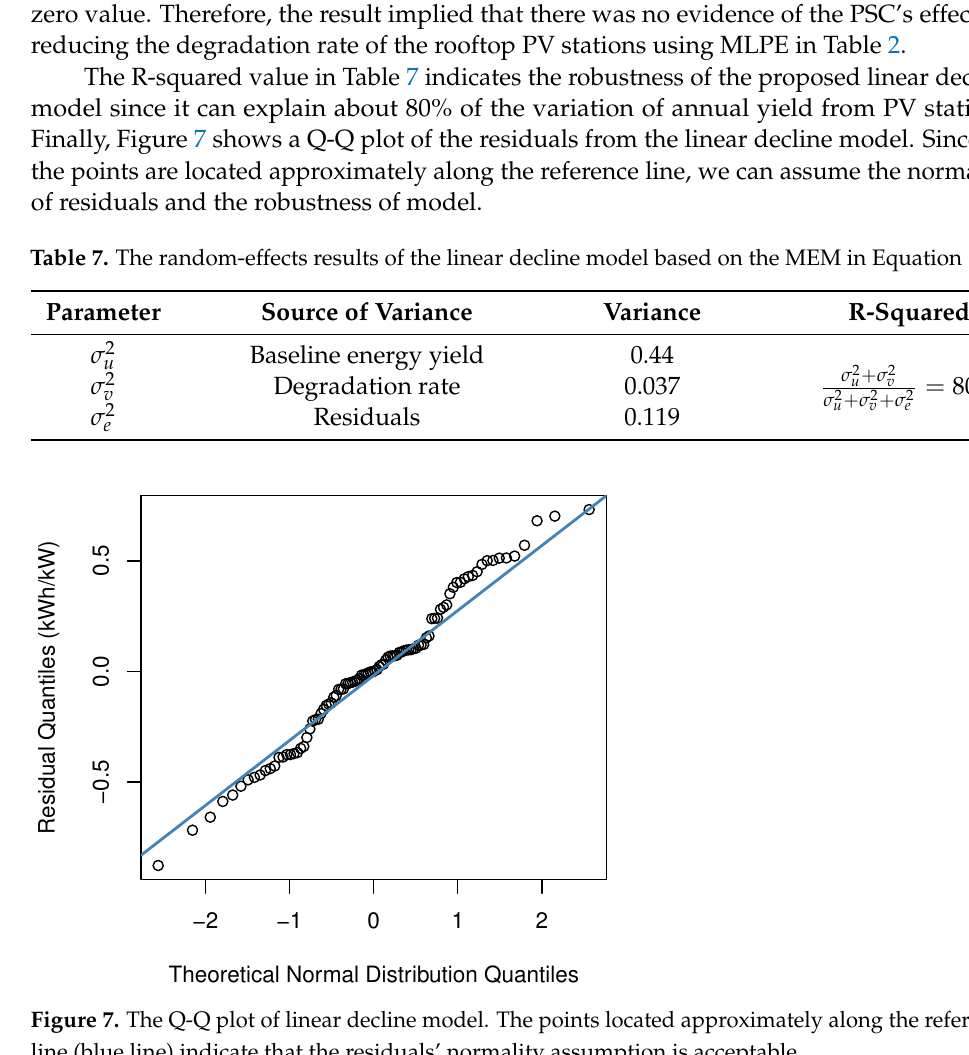
Figure 7. The Q-Q plot of linear decline model. The points located approximately along the reference line (blue line) indicate that the residuals’ normality assumption is